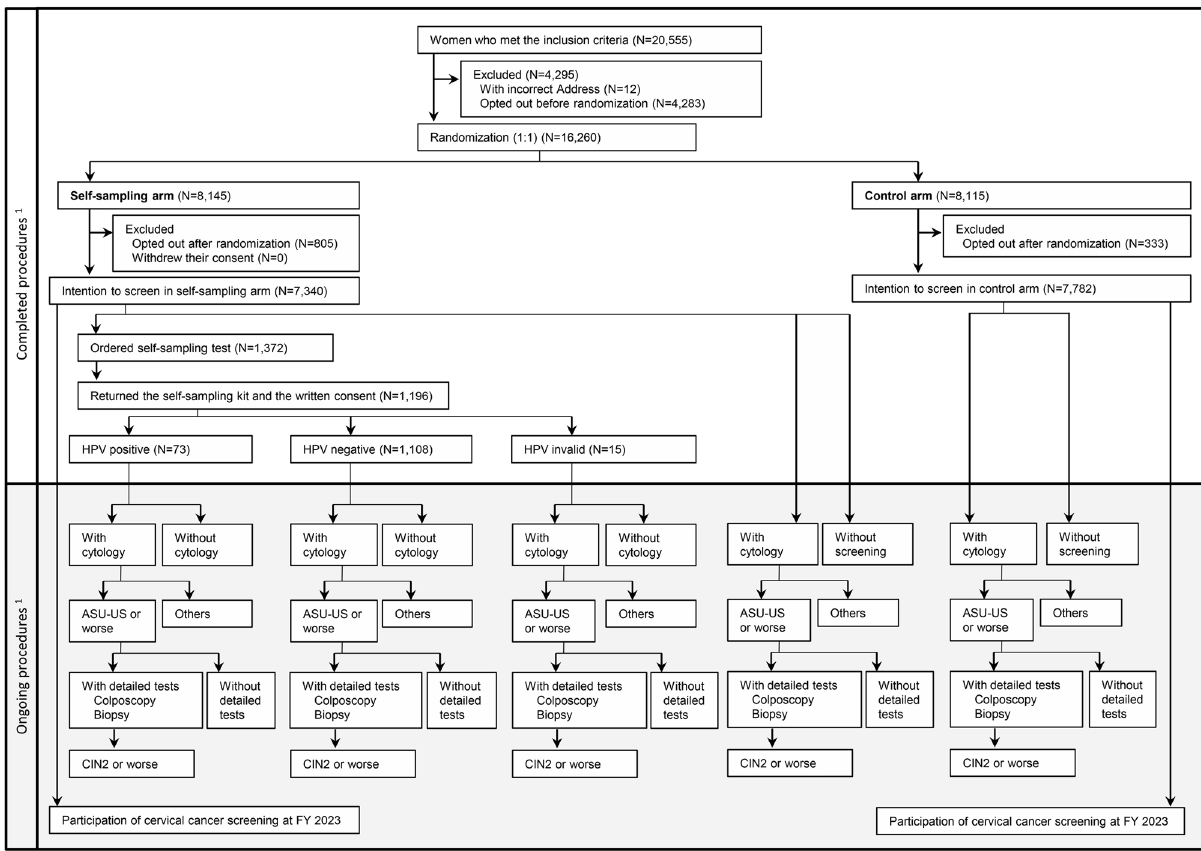
Figure 1. Flowchart of this study. HPV human papillomavirus, ASC-US atypical squamous cells of undetermined significance, CIN cervical intraepithelial neoplasia. 1 At the time of database lock for this analysis (October 6,